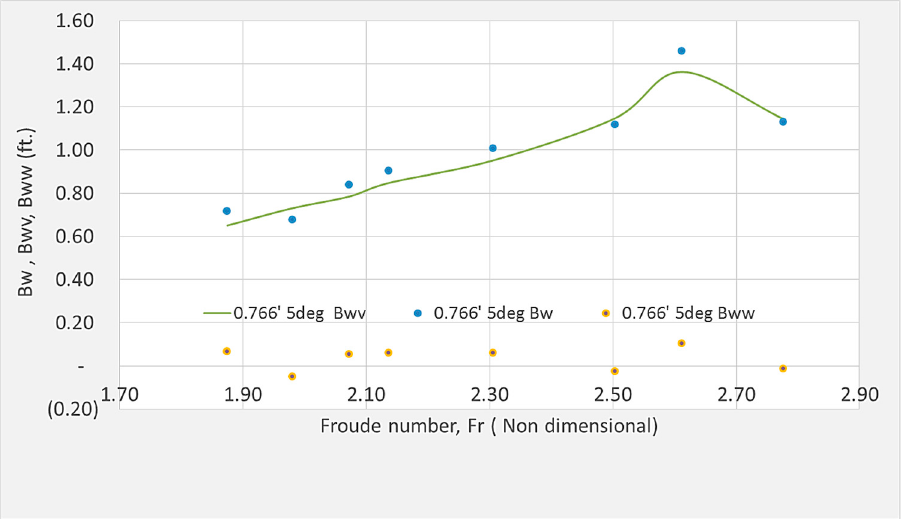
B = B . (cid:2933) (cid:2933)(cid:2932)